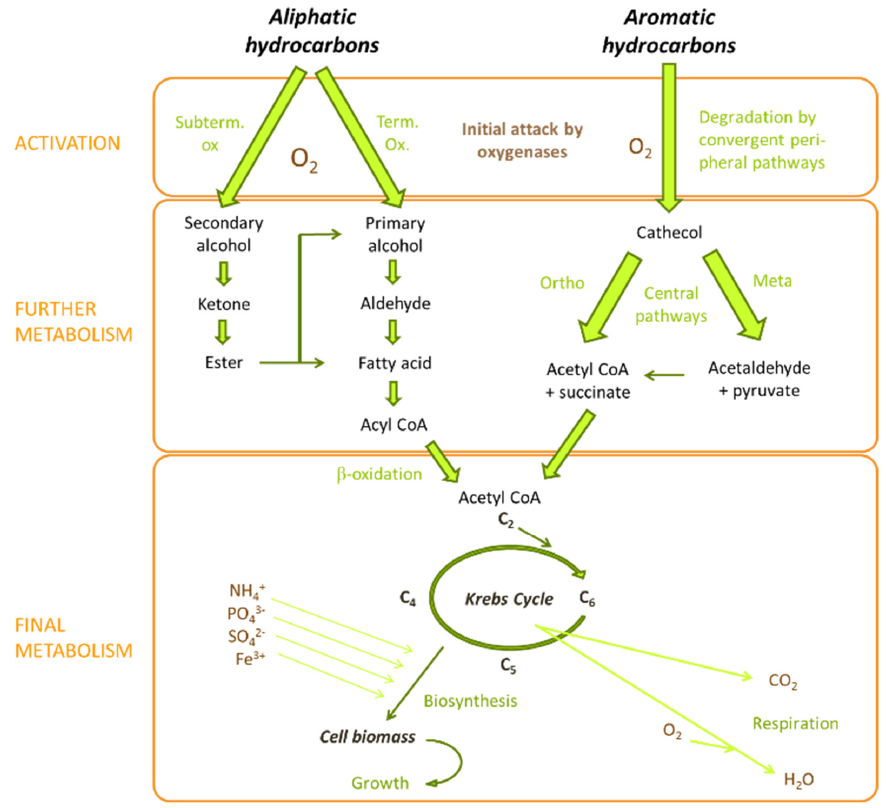
Figure 2. Degradation of aliphatic and aromatic hydrocarbons by aerobic bacteria. Subterm. ox.: subterminal oxidation; Term. ox.: terminal oxidation; Ortho: ortho cleavage pathway; Meta: meta cleavage patway; CoA: coenzyme A.